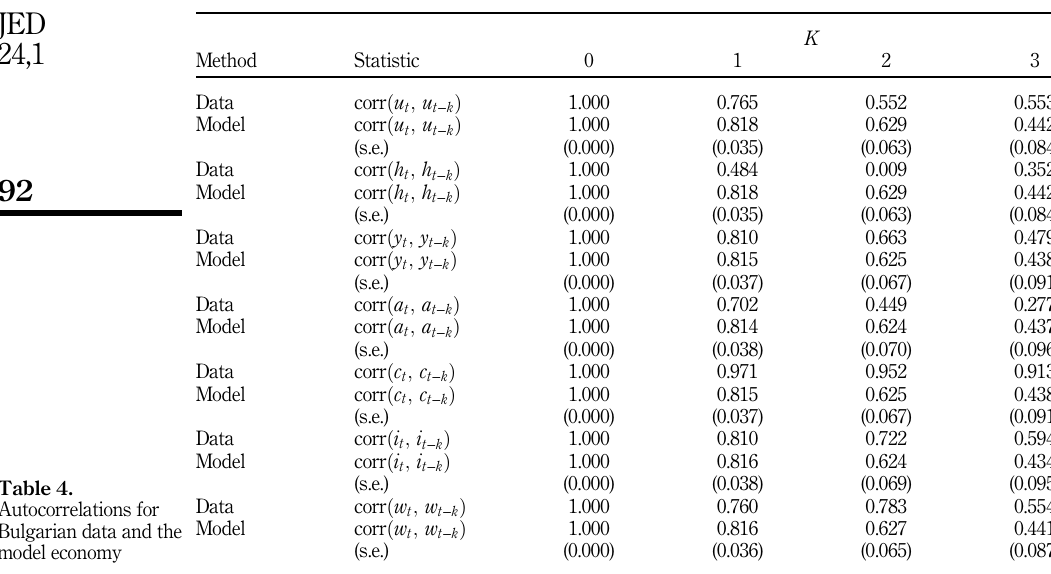
Table 4. Autocorrelations for Bulgarian data and the model economy